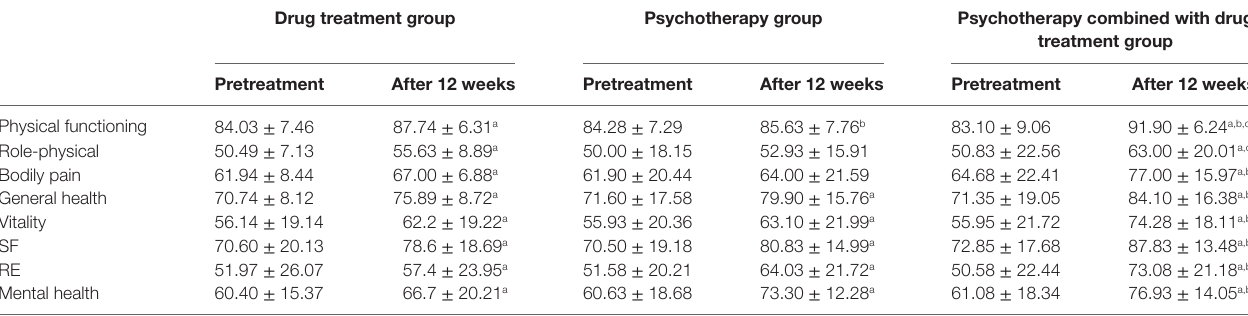
Compared with prior treatment, a P < 0.05; Compared with the drug group, b P < 0.05; Compared to psychotherapy, c P < 0.05.